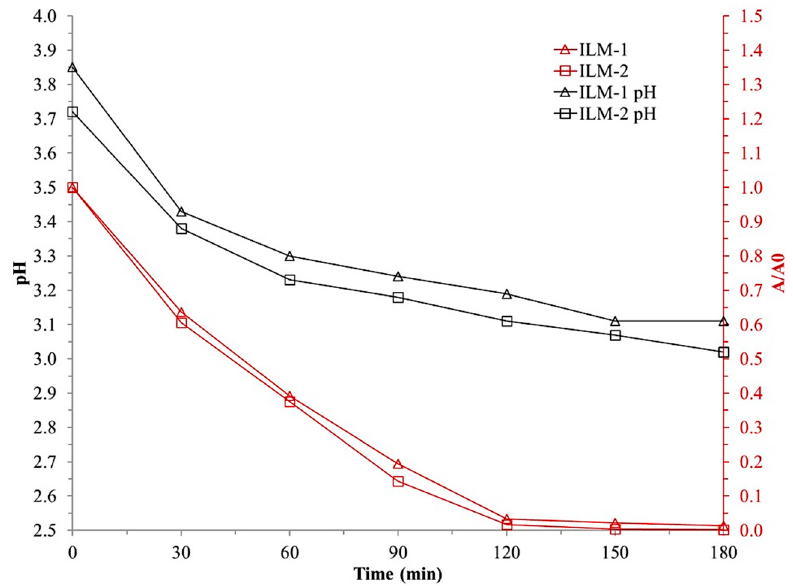
Figure 8. E ff ect of ilmenite particle size on discoloration ([H 2 O 2 ] = 10 mM, pH 0 = 3.8, UVC, Ilmenite loading = 0.7 g/L).